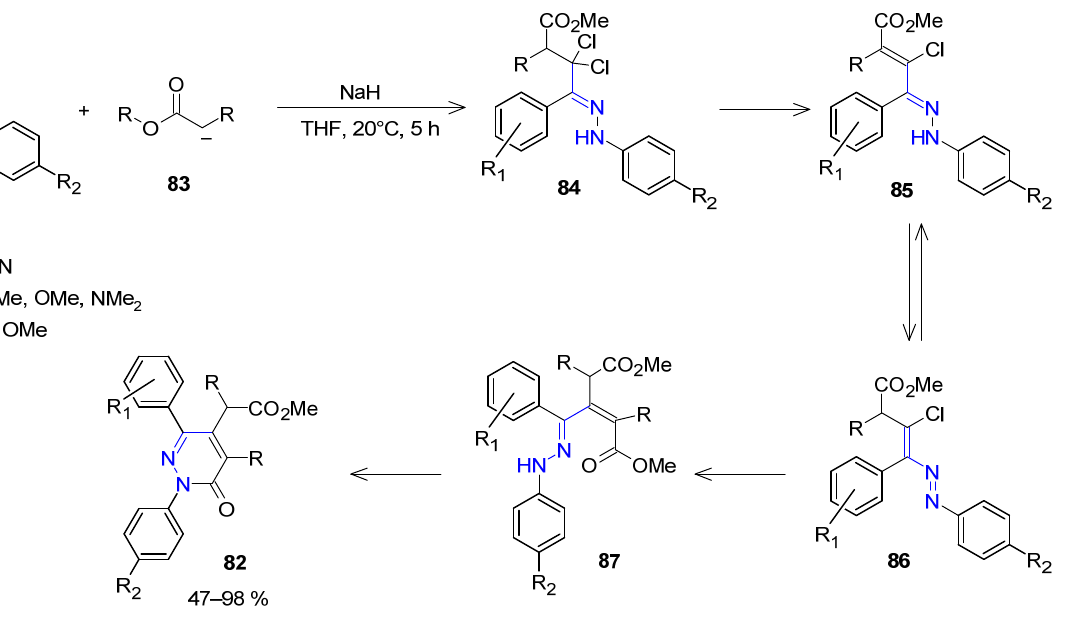
Scheme 16. Reaction mechanism for synthesis of pyridazone derivatives 82 from 4,4 ‐ dichloro ‐ 1,2